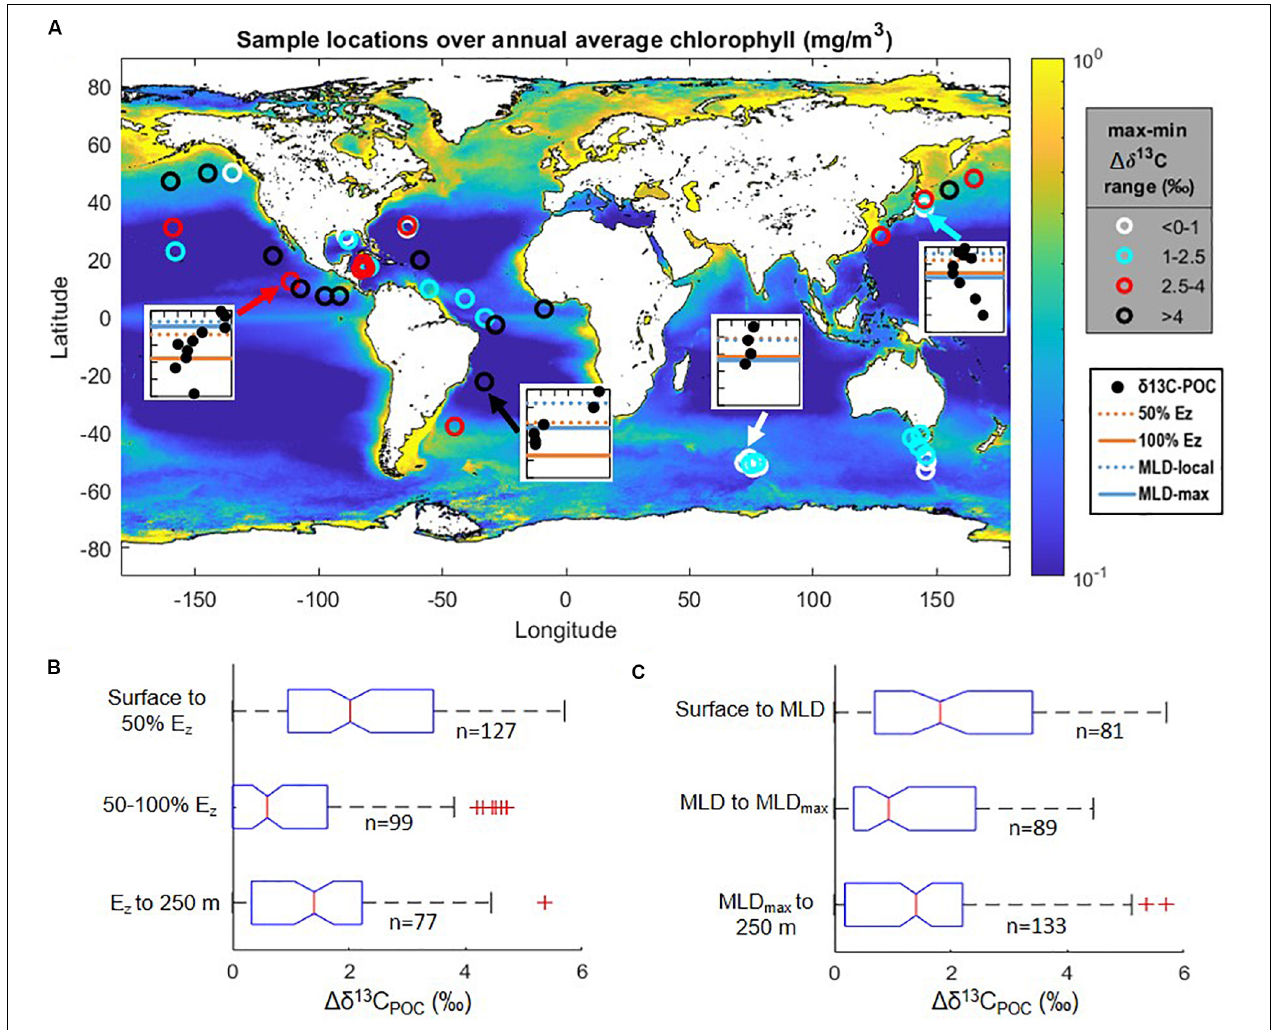
FIGURE 1 | (A) Data locations (open circles) shown over mapped annual climatological surface ocean chlorophyll concentrations from Melin (2013). Symbols are color-coded according to the ranges in (cid:49) δ 13 C POC values observed in the upper 250 m (overlying maximum minus underlying minimum; see Figure 2 ). Insets show examples of four vertical profiles of δ 13 C POC values (filled black circles): each inset spans from the surface down to 250 m on the vertical axis and a δ 13 C range of − 27 to − 21 on the horizontal axis (see also Supplementary Figure S1 ); horizontal lines indicate depths of the mixed layer and euphotic zone as indicated in the legend. (B,C) Normalized (cid:49) δ 13 C POC values among all compiled data: medians (center vertical lines), interquartile range (boxes), 99% intervals (brackets), and outliers (cid:104) (individual points); (B) when grouped by standardized euphotic zone depth intervals (100% E z , depth at which irradiance is 0.1% of surface values); (C) when grouped by local mixed layer depth (MLD) and maximum annual mixed layer depth (MLD max ). (cid:49) δ 13 C POC indicates δ 13 C POC values normalized to the minimum δ 13 C POC value found within the upper 250 m at each station, as described in the text. Depth ranges and statistical results are further outlined in Supplementary Table S3